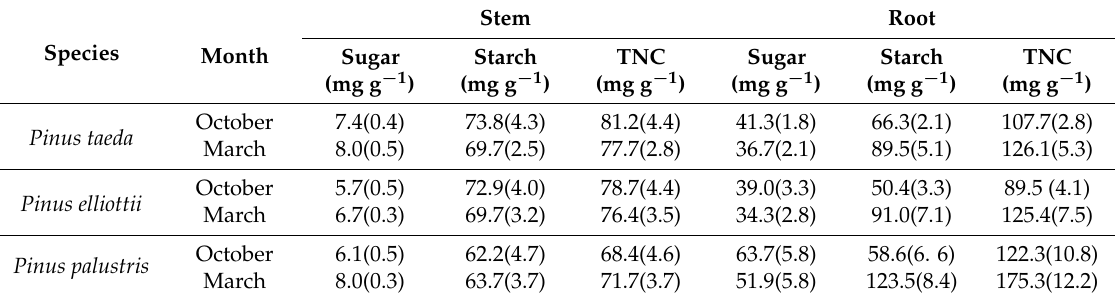
Table 1. Mean ( ± SE) sugar, starch, and TNC for each species-by-organ-by-time combintaion.